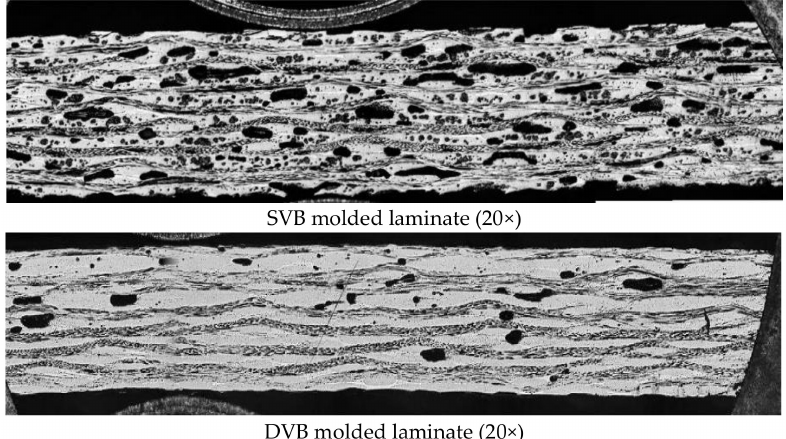
Figure 4. SVB and DVB Micrograph. Reprinted with permission from